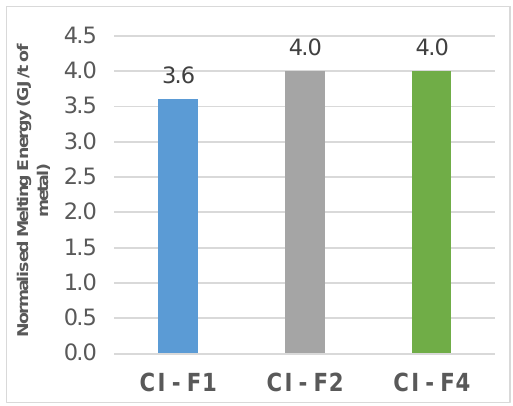
Figure 8. Melting energy per ton of liquid metal in three di ff erent cast-iron foundries.